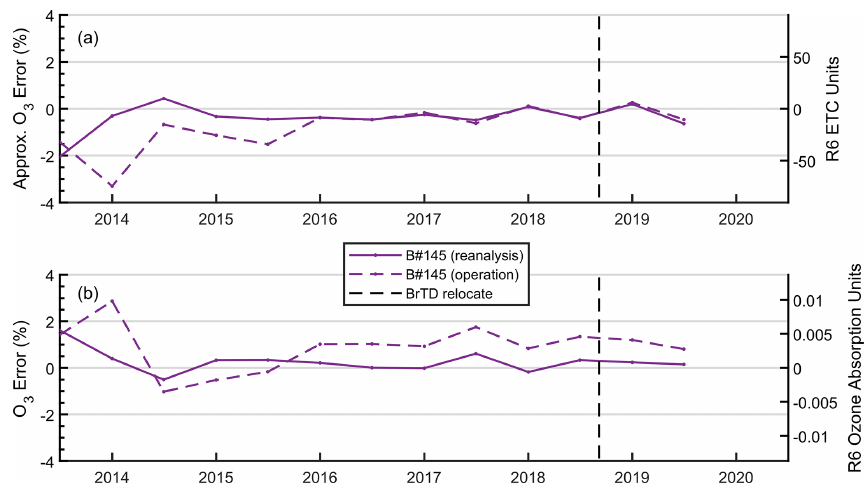
Figure B1. Comparison between reprocessed and operational data from Brewer no. 145. (a) Relative systematic uncertainties in ETCs and (b) ozone absorption coefficients estimated using Model 3. Discerption of y axes in Fig. 3. Each point on the graph represents a 6-month average. The black dash line represents the time when BrT-D was relocated to